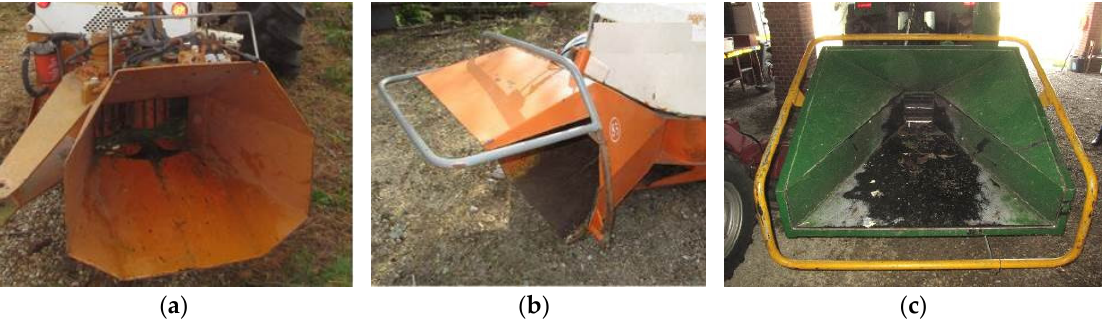
Figure 3. Some examples of protective devices that do not comply with standard requirements. ( a ) This machine presented no safety devices around the edges of infeed chute. ( b ) Side and upper protective devices were present, but there was no lower protective device (mandatory for the standard). ( c ) The infeed chute was equipped with side, lower and top protective devices, but in order to comply with the safety standard draft, the top protective bar should have a separate control or be replaced by an emergency stop.